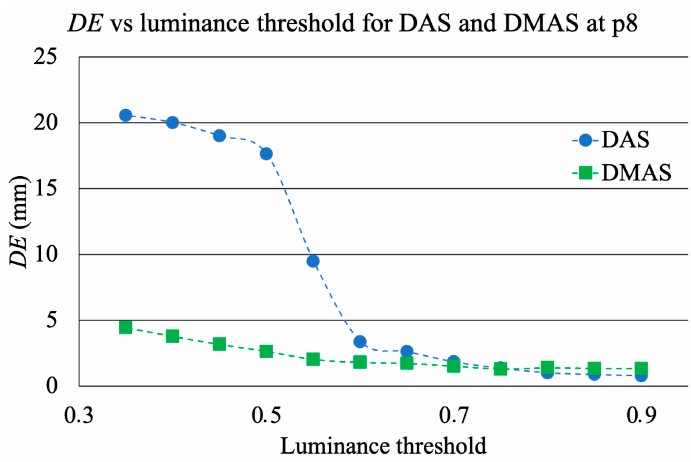
Figure 18. Evolution of DE depending on the luminance threshold for both algorithms.